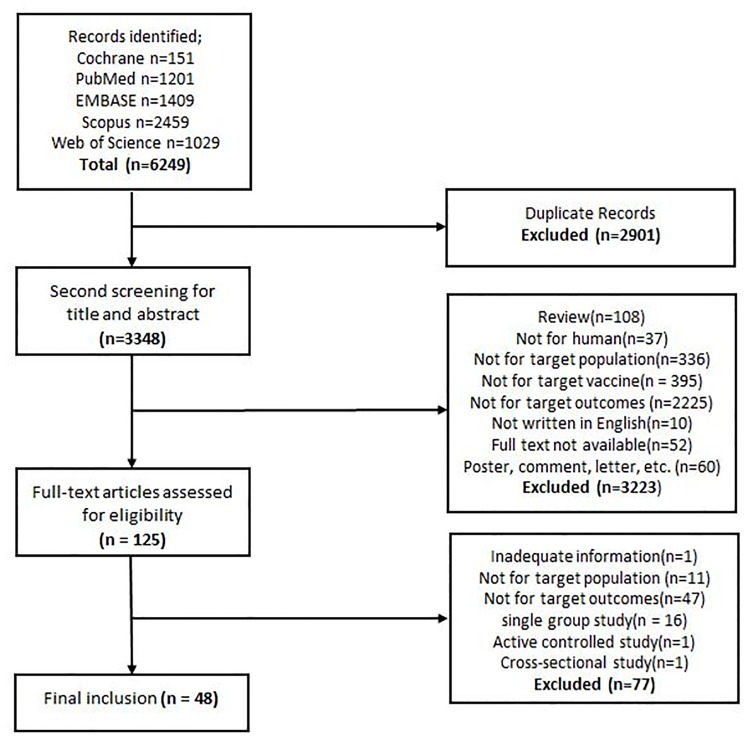
PRISMA flow diagram of study selection for the meta-analysis.